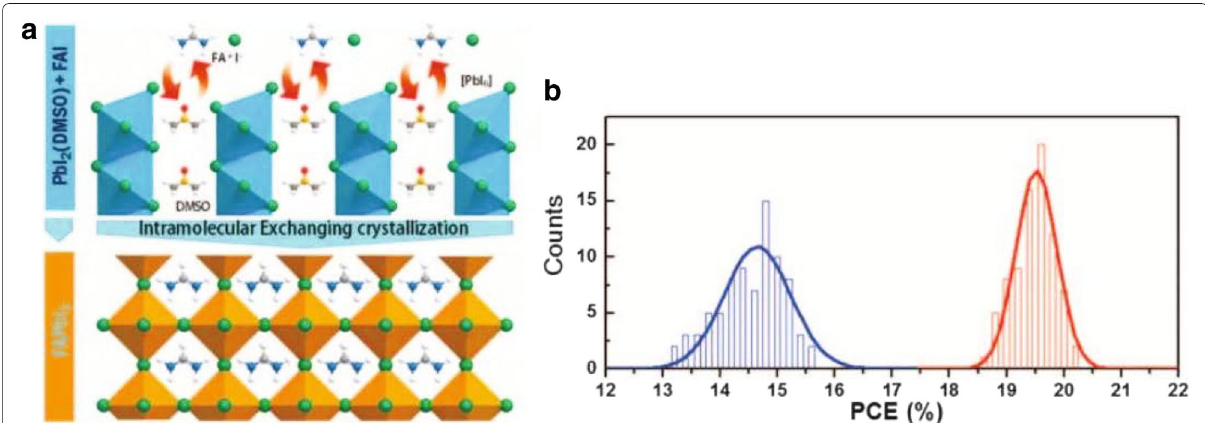
Fig. 3 PbI 2 complex formation and X-ray diffraction. a Schematics of FAPbI 3 perovskite crystallization involving the direct intramolecular exchange of DMSO molecules intercalated in PbI 2 with formamidinium iodide (FAI). The DMSO molecules are intercalated between edge-sharing [PbI 6 ] octahedral layers. b Histogram of solar cell efficiencies for each 66 FAPbI 3 -based cells fabricated by IEP and conventional process [26]